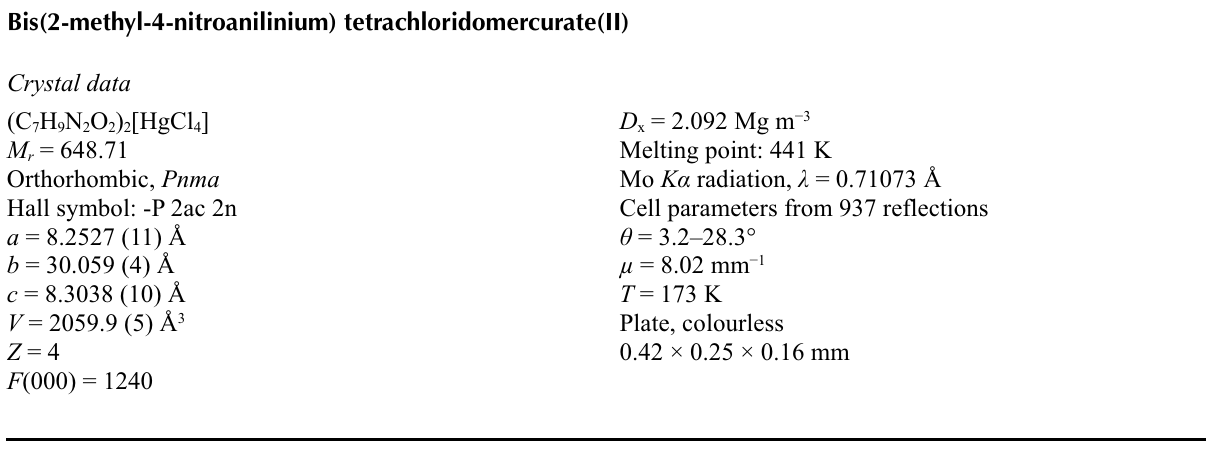
Packing arrangement viewed down the c